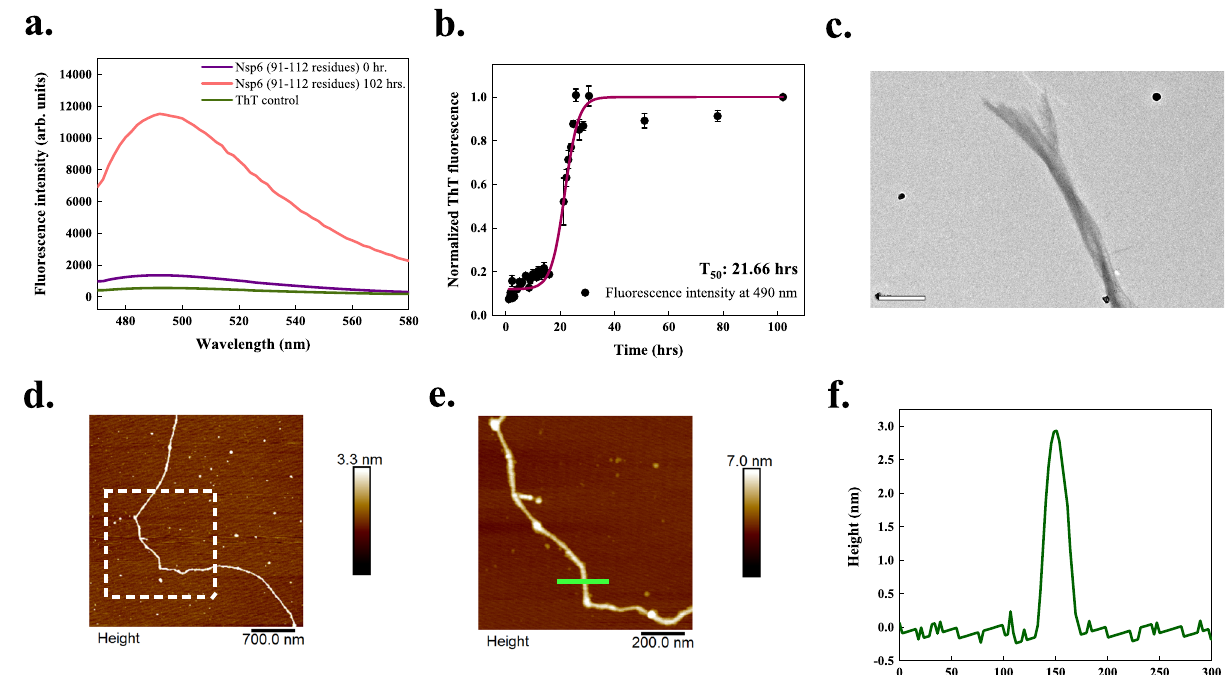
Fig. 6 | In vitro aggregation of NSP6-p of SARS-CoV-2. a ThT fl uorescence scan ( λ ex 440nm) indicates an increase of ~10-fold at λ max with NSP6-p incubated sam- ple. b Aggregation kinetics of NSP6-p monitored using ThT fl uorescence. Each dotted symbol represents the average value of two technical replicates and error bar represents the SEM of these replicates. The wine-coloured line shows the sig- moidal fi tting of data points that determines the T 50 of this reaction to be 21.66±0.8h. c Under HR-TEM, 240h incubated aggregates are longer and bran- ched, possessing twisted morphology; the scale bar represents 500nm. Four